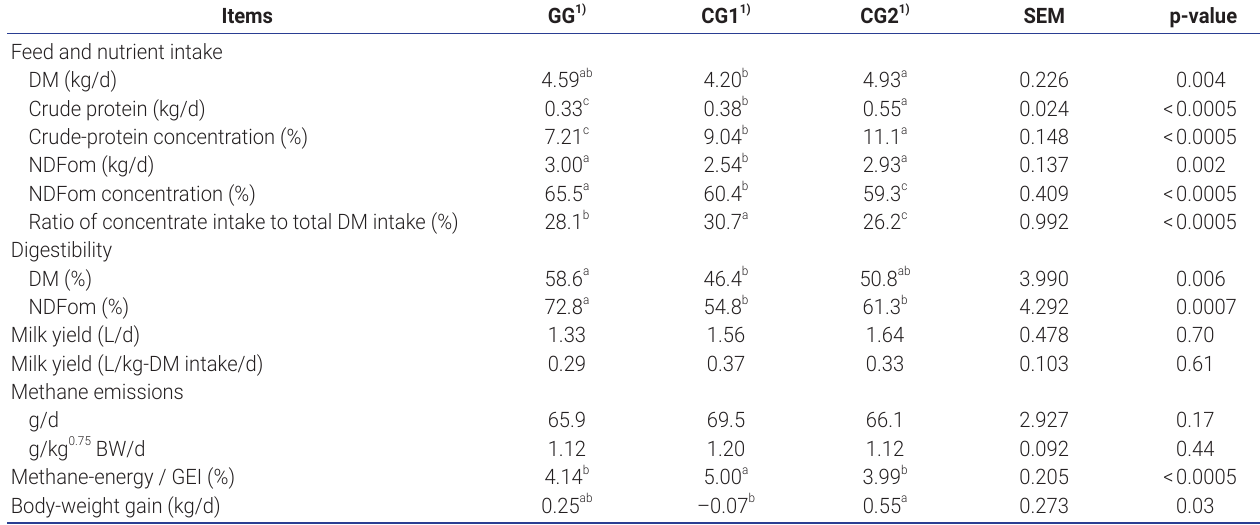
Table 4. Feed and nutrient intake, digestibility, milk yield, methane emissions, and body-weight gain in Fogera dairy cows (Exp 2)